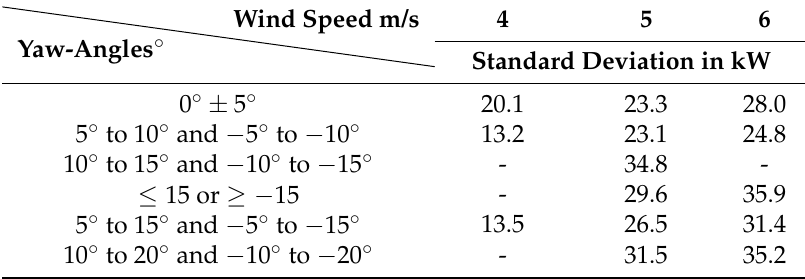
Table 4. Standard deviations (in kW) of SMV6 SCADA data in different speed bins with yaw offsets during the experiment.